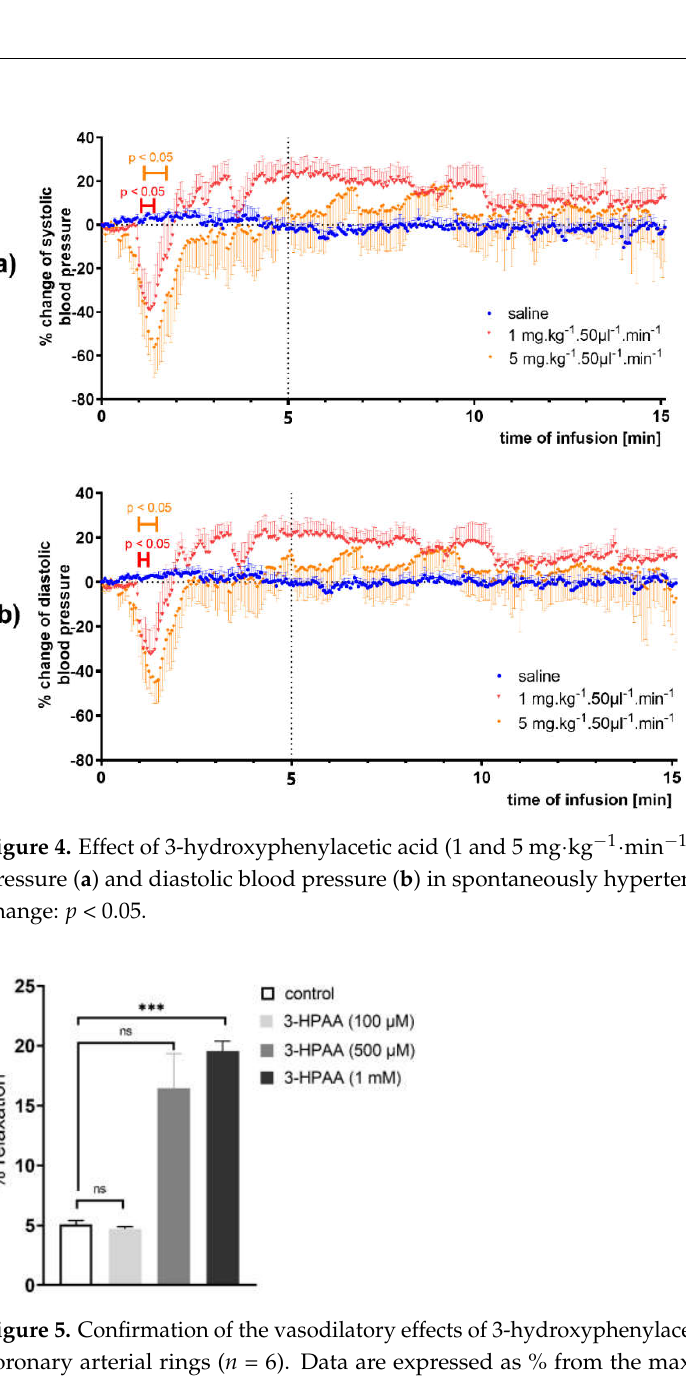
Figure 5. Confirmation of the vasodilatory effects of 3-hydroxyphenylacetic acid (3-HPAA) in por- cine coronary arterial rings ( n = 6). Data are expressed as % from the maximal relaxation induced by sodium nitroprusside (100 µM). Significant change: *** p < 0.001 vs. control, ns—not significant.